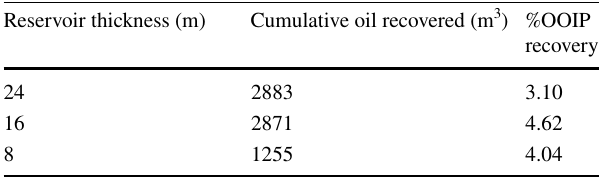
Table 6 Oil recovery at the end of the 104 days of PIHC Reservoir thickness